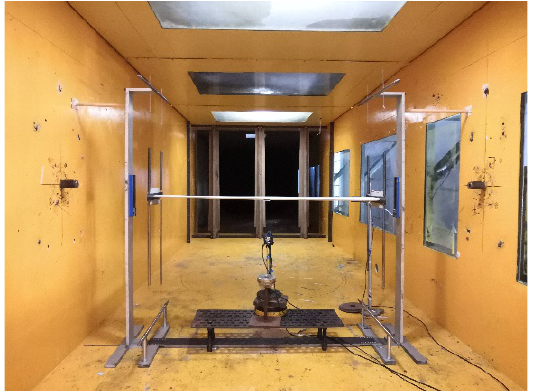
Figure 11. Integrated transfer function identification test.